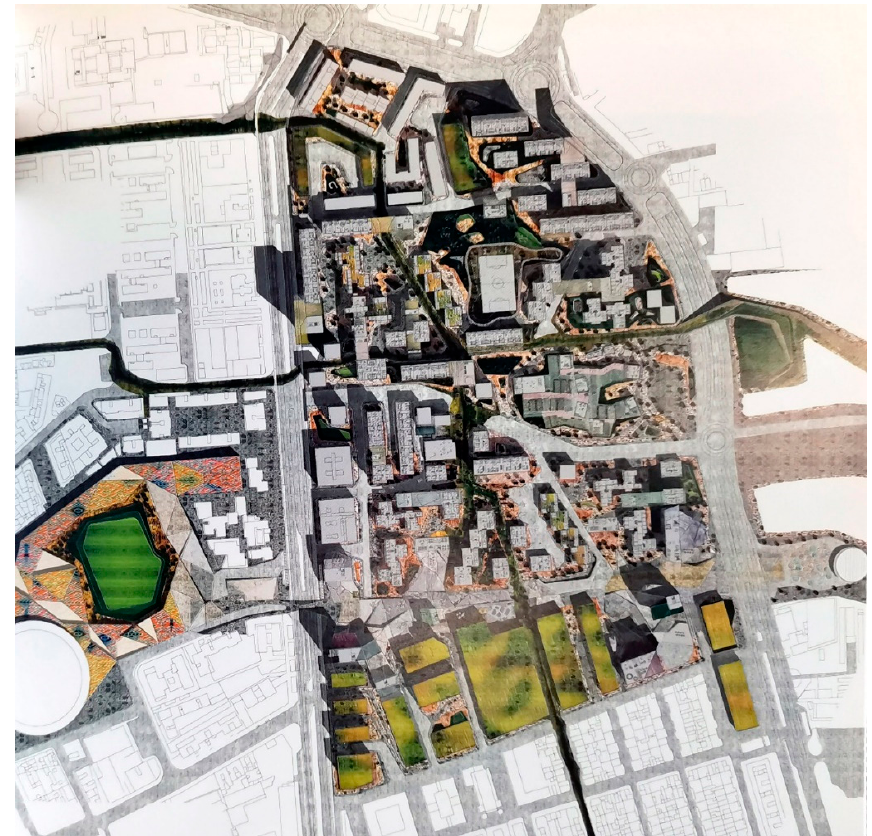
Figure 18. La Ciudad Maclada masterplan, La Paz, Murcia. Drawing: Xpiral & Colectivo Baquía.